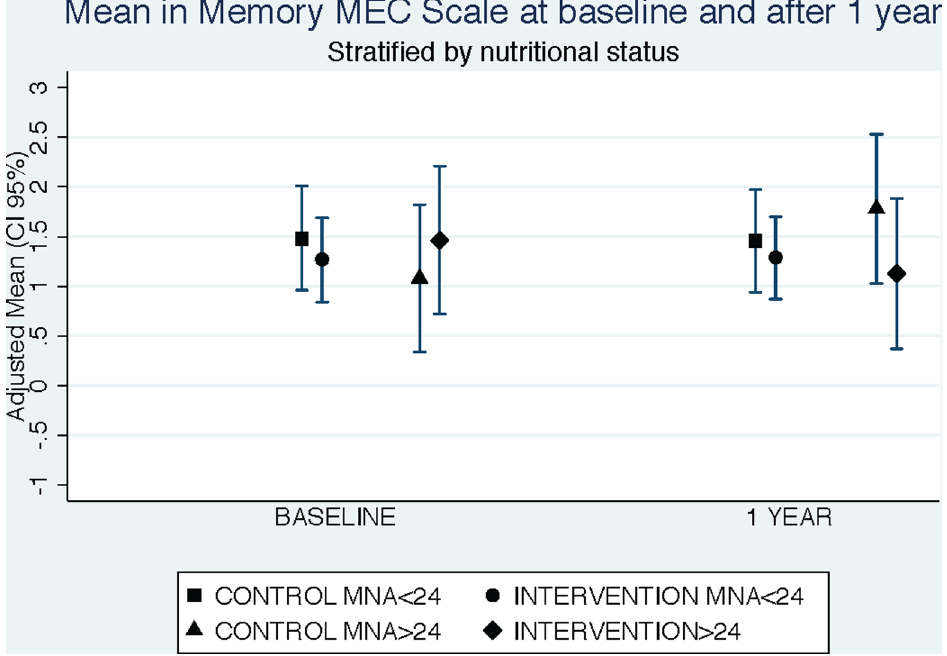
Fig 2. Mean in memory MEC scale at baseline and after 1 year of intervention stratified by treatment and by nutritional status. Adjusted for: cognitive stimulation, physical activity, educational level, and occupation. Ancova test was used to calculate adjusted